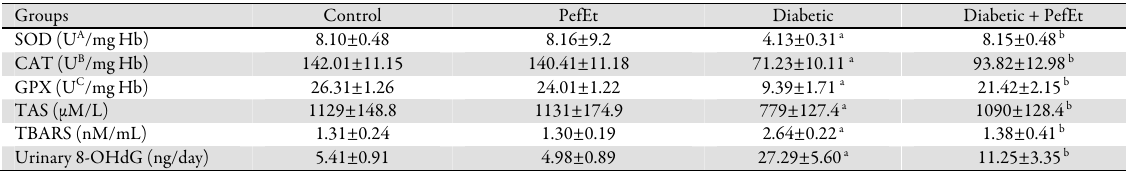
Values are given as mean±SD in each group. a=Statistical significant difference between diabetic and control rats at (p<0.01). b=Statistical significant difference between diabetic rats treated with PefEt and the diabetic at (p<0.01). U A =enzyme concentration required to inhibit to 50% in one minute